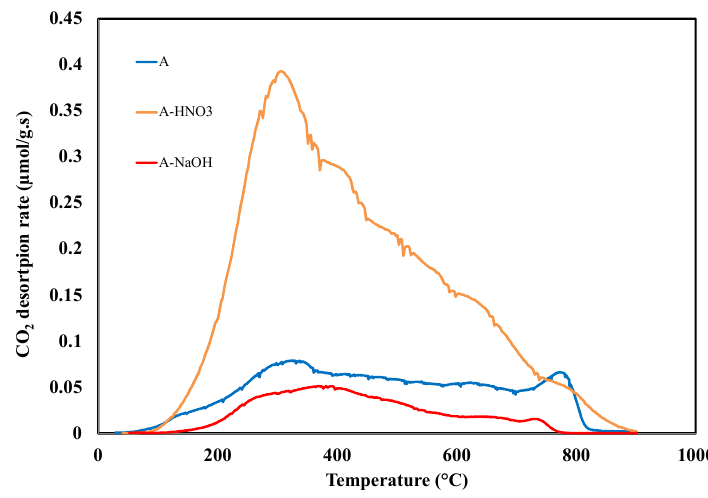
Figure 6. CO 2 desorption profiles of sample A and samples of A treated by HNO 3 or NaOH.